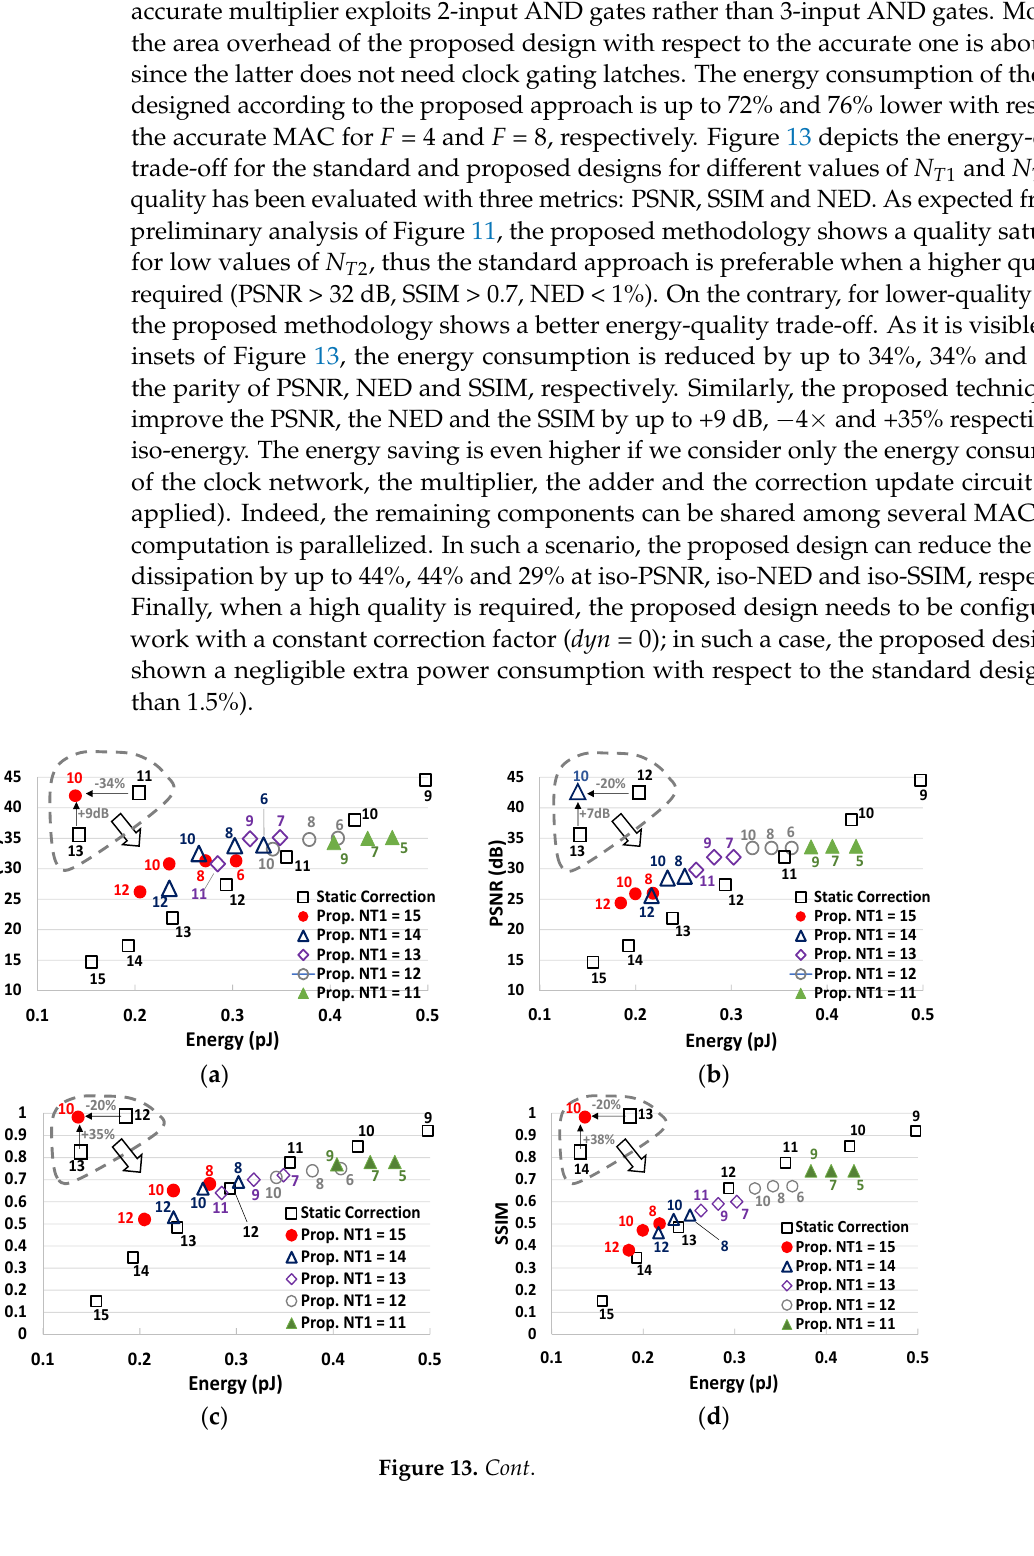
Table 2. Energy dissipation (pJ) of the standard and proposed designs.